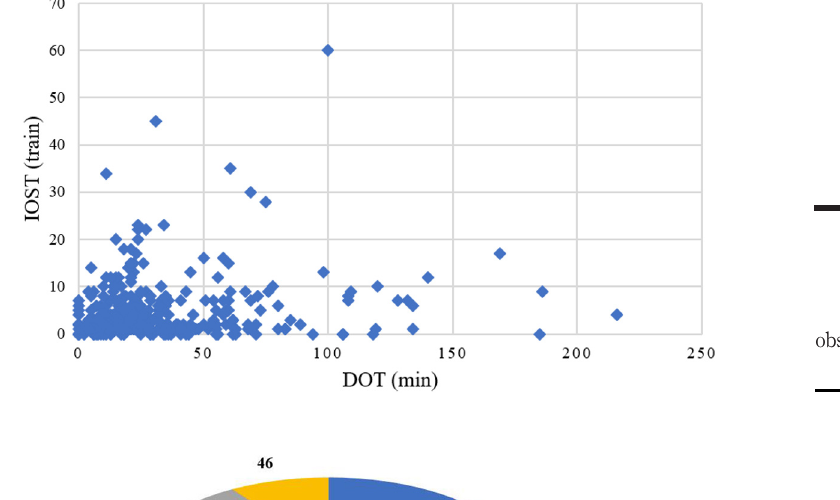
Figure 2. Distribution of observed accidents on DOT and IOST